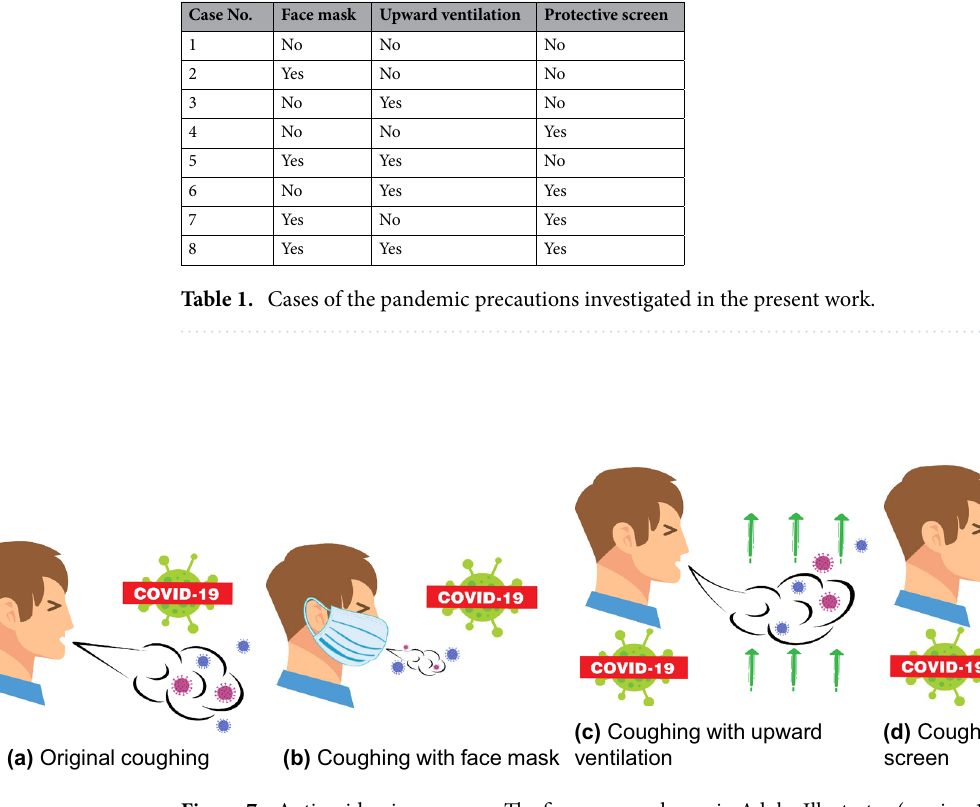
Figure 7. Anti-epidemic measures. The figures were drawn in Adobe Illustrator (version